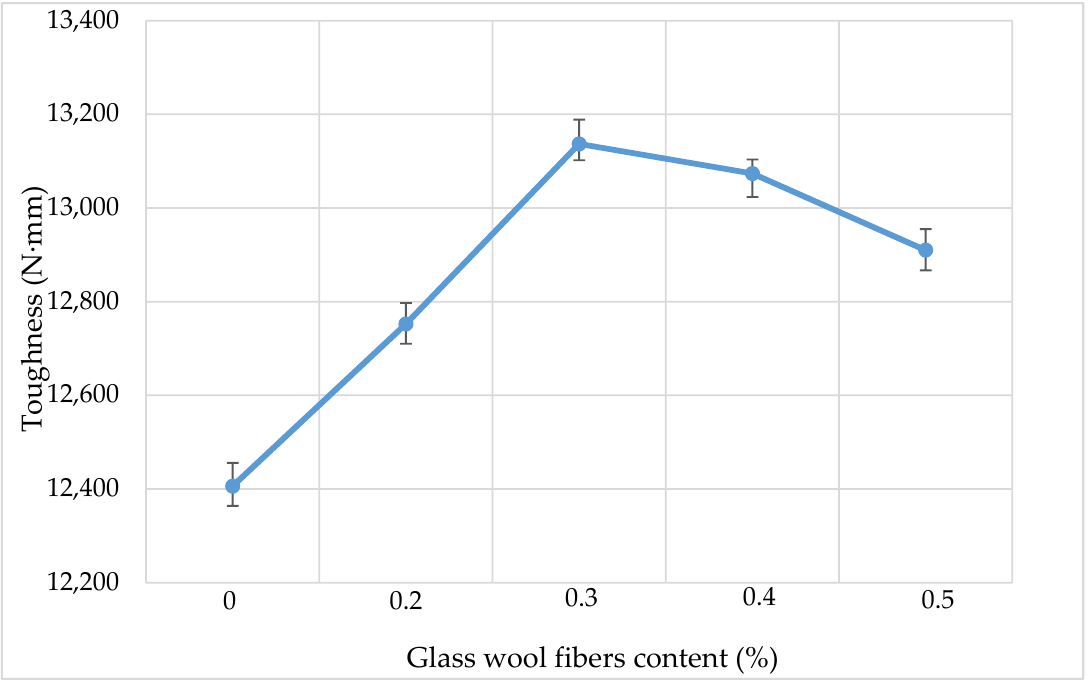
Figure 9. Toughness results.